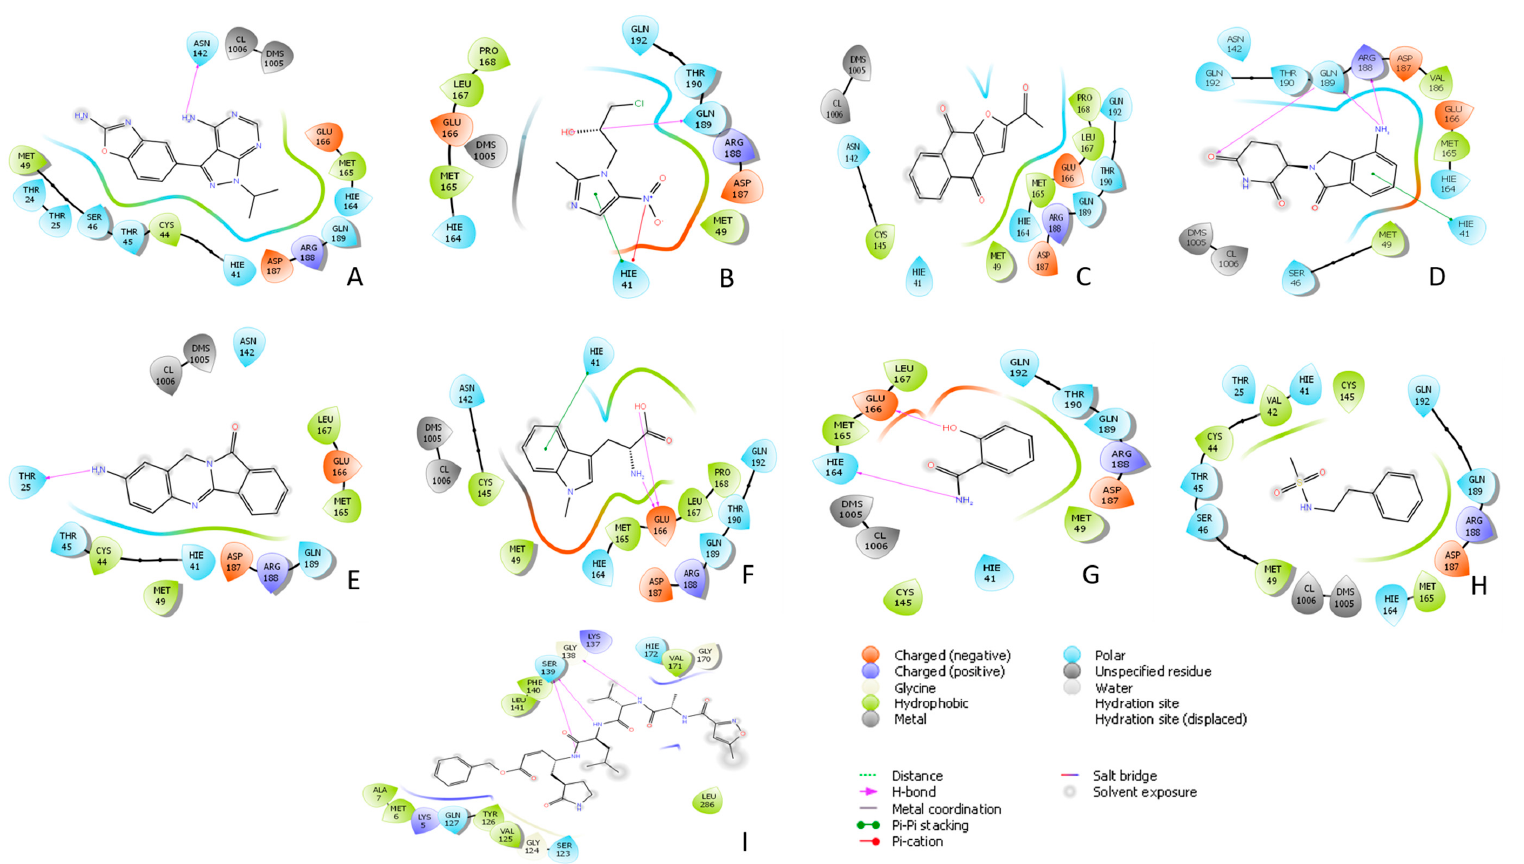
Figure 4. 2D docking interactions of ( A ) Sapanisertib, ( B ) Ornidazole, ( C ) Napabucasin, ( D ) Lenalidomide, ( E ) Daniquidone, ( F ) Indoximod, ( G ) Salicylamide, and ( H ) Control 1 with SARS-CoV-2 M pro (PDB ID: 5R7Y); ( I ) Control 2 with SARS-CoV-2 M pro (PDB ID: 7BQY). The colors indicate the residue type: red-acidic, green-hydrophobic, purple-basic, blue-polar, light gray-other, darker gray-metal atoms. Interactions with the protein are marked with lines between ligand atoms and protein residues: solid pink—H-bonds to the protein backbone, dotted pink-H-bonds to protein side chains, green—pi-pi stacking interactions, orange-pi-cation interactions. Ligand atoms that are exposed to solvent are marked with gray spheres. The protein “pocket” is displayed with a line around the ligand, colored with the color of the nearest protein residue. The gap in the line shows the opening of the